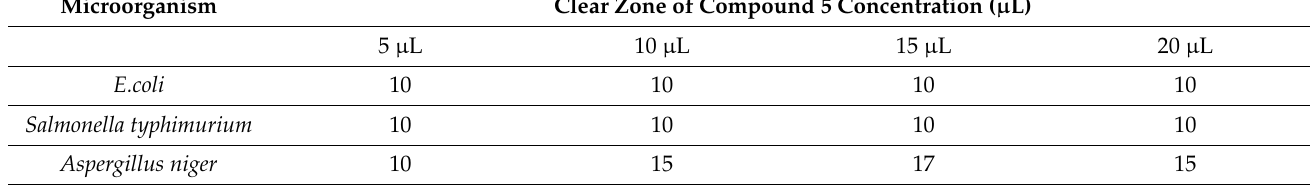
Table 4. Minimal Inhibitory Concentration (MIC) for the highest clear zones of the compound 5 against E.coli, Salmonella, and Aspergillus